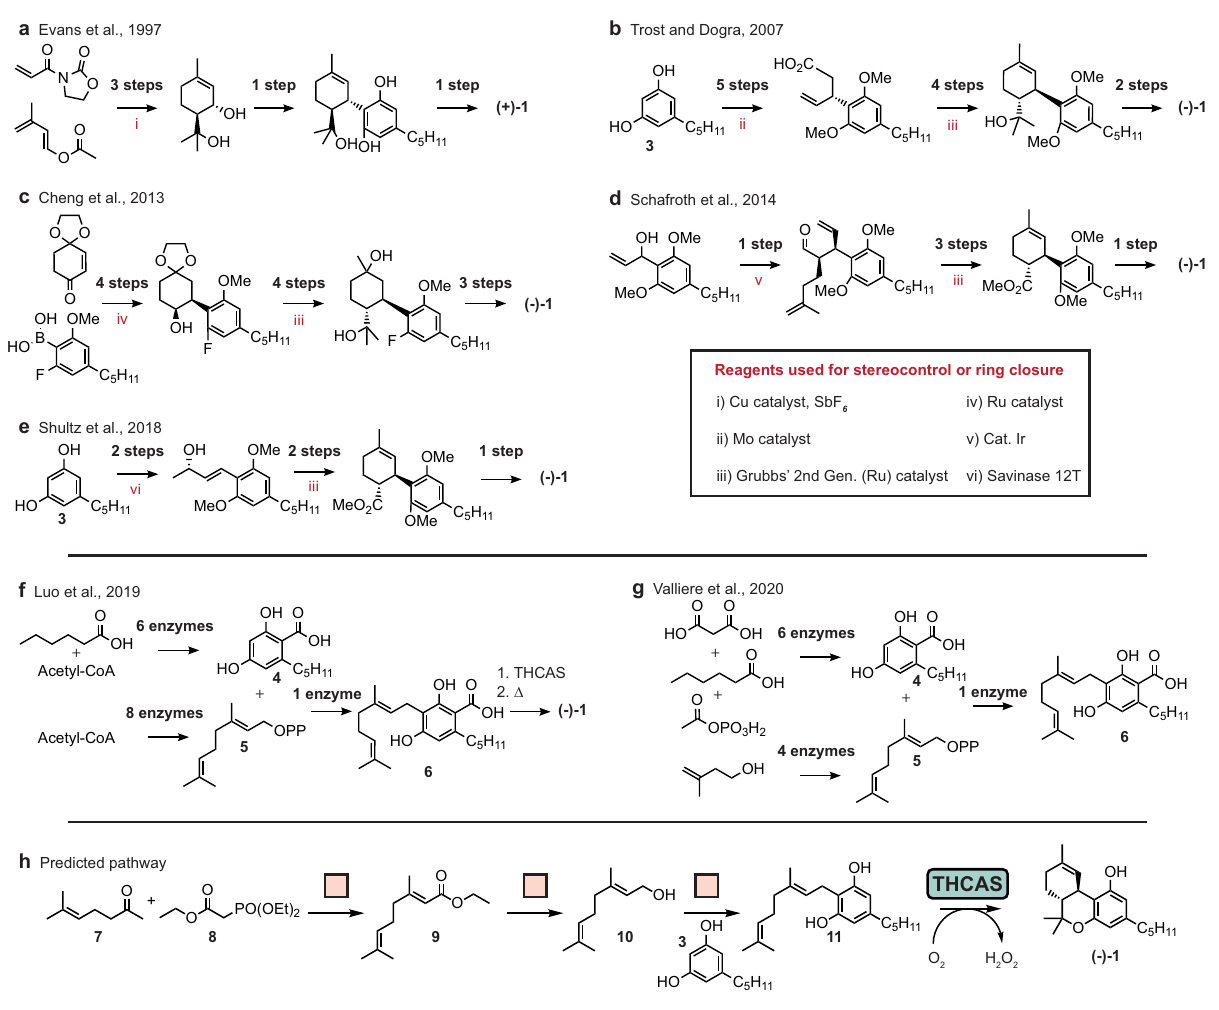
Fig. 7 | Previously published and newly proposed syntheses of dronabinol. a – g Overview of published enantioselective syntheses of dronabinol. h